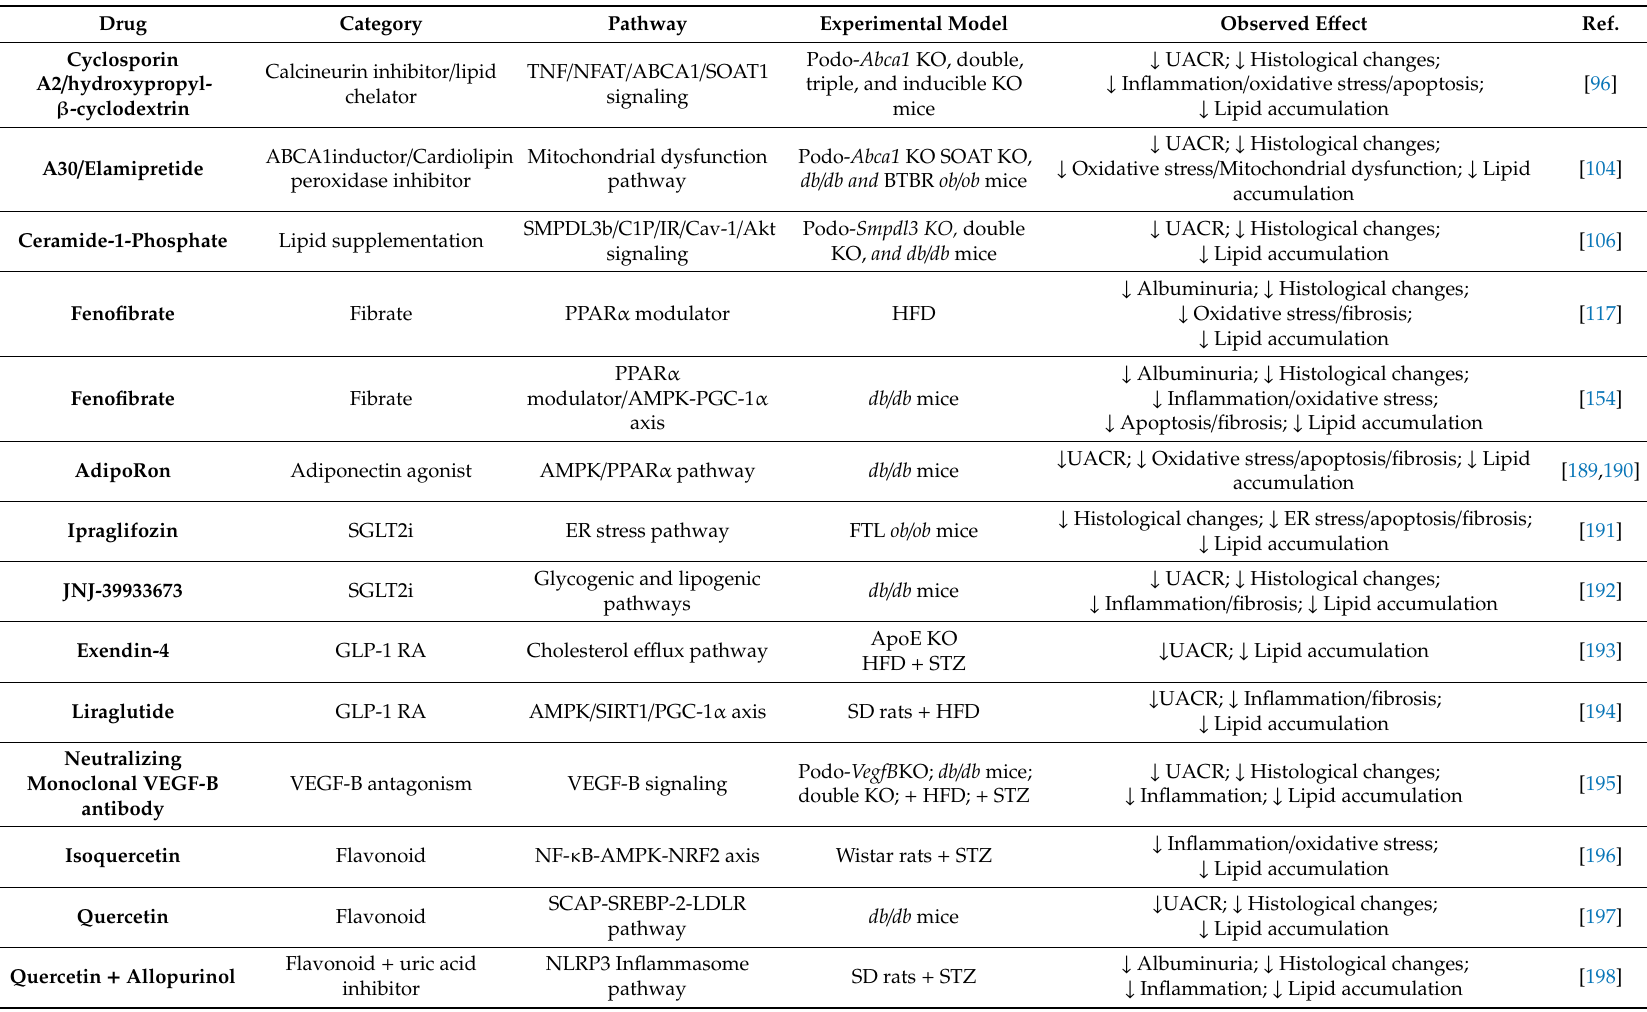
Table 2. Summary of selected preclinical studies reporting renoprotective e ff ects and reduction of kidney lipid